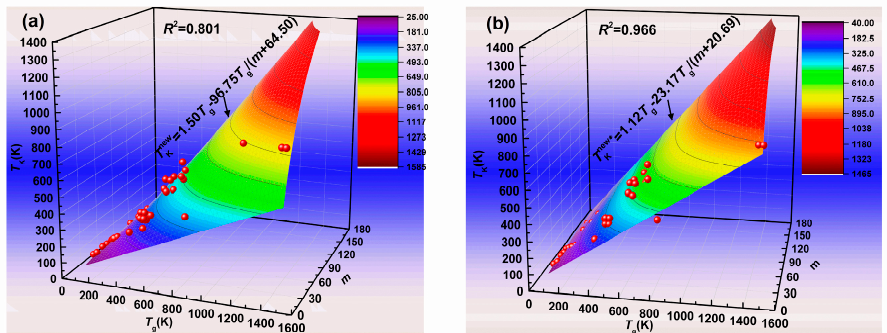
Figure 4. The predicted Kauzmann temperature obtained by Equation (17). ( a ) Λ b = 43 and Λ c = 1.5; ( b ) Λ b = 18.47 and Λ c = 1.12.